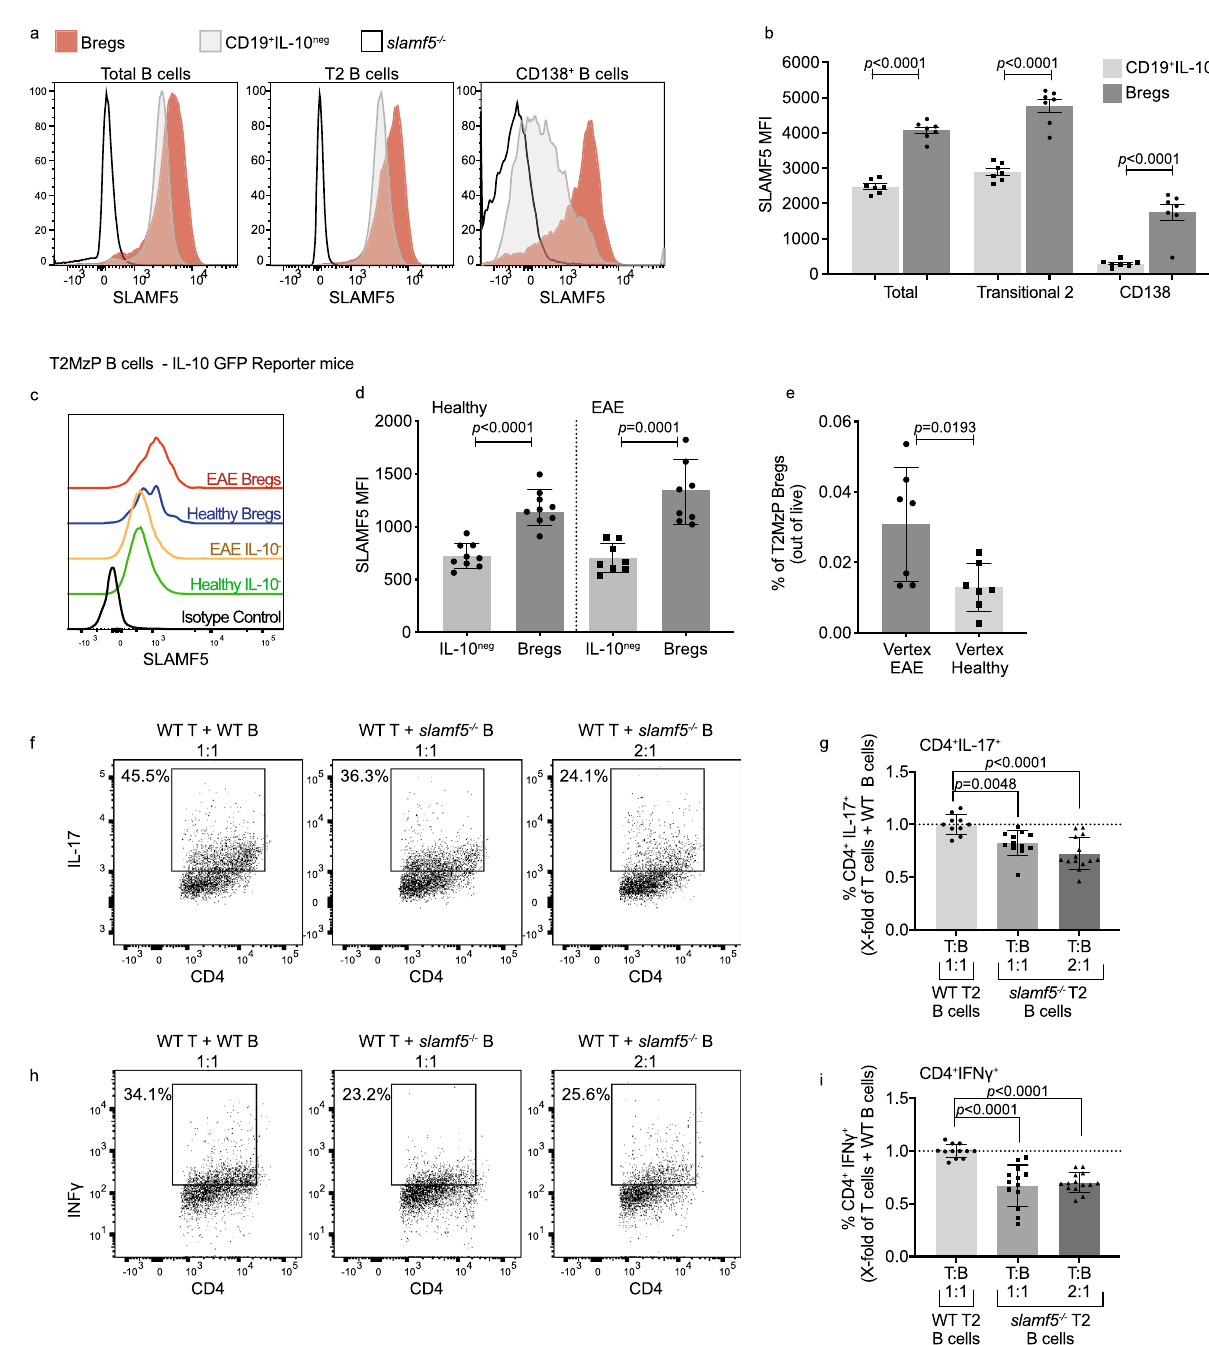
Fig. 3 SLAMF5 is highly expressed on Bregs and regulates their functionality. a , b Analysis of SLAMF5 expression on splenic regulatory B compared to non-Bregs (B cells IL-10 neg ) of WT EAE (MOG 35-55 )-induced mice. a Representative histograms, and b bar charts showing the SLAMF5 MFI on B-cell subpopulations according to the following markers: total B cells (CD19 + ), T2 B cells (CD19 + CD24 + CD21 + CD23 + ), and CD138 + B cells (CD19 + CD138 + ). Populations are divided into IL-10 + (Bregs) and IL-10 neg (non-Bregs) (non-Bregs n = 7; Bregs n = 7, two independent experiments). c – e Spleens of Vert-x mice, healthy or EAE-induced, were harvested and analyzed for SLAMF5 expression on IL-10 + or IL-10 neg T2MzP cells. c Representative histogram and d bar graph showing SLAMF5 MFI. (EAE: Bregs n = 8; non-Bregs n = 8; healthy: Bregs n = 9 non-Bregs n = 9, two independent experiments). e Spleens were analyzed for percentages of T2MzP Bregs (IL-10 + ) (healthy n = 7; EAE n = 7, two independent experiments). f – i Sorted CD4 + CD25 - splenic T cells of WT EAE-induced mice were co-cultured 1:1 or 2:1 for 72 h in the presence of anti-CD3 and anti-CD28 Abs with WT or slamf5 − / − sorted splenic transitional 2 B cells (CD19 + CD23 + CD21 + ). Cells were analyzed for ( f – g ) IL-17 expression, shown as ( f ) representative dot plots, and ( e ) bar graph (WT T:WT B 1:1 n = 10; WT T: slamf5 − / − B 1:1 n = 12; WT T: slamf5 − / − B 2:1 n = 14, fi ve independent experiments) and ( h , i ) IFN γ expression, shown as ( h ) representative dot plots, and ( i ) bar graph. (WT T:WT B 1:1 n = 12; WT T: slamf5 − / − B 1:1 n = 13; WT T: slamf5 − / − B 2:1 n = 14, fi ve independent experiments). Data expressed as mean ± s.e.m. ( b ) and mean ± s.d. ( d , e , g , i ). Unpaired Student ’ s t test with 95% con fi dence levels two-tailed ( b , d , e ) or ordinary one-way ANOVA with Dunnett multiple comparison tests ( g , i ). Gating strategy for a and b is shown in Supplementary Fig. 2b, gating strategy for c and d is shown in Supplementary Fig. 6d, gating strategy for h and i is shown in Supplementary Fig. 1b (I., III.).